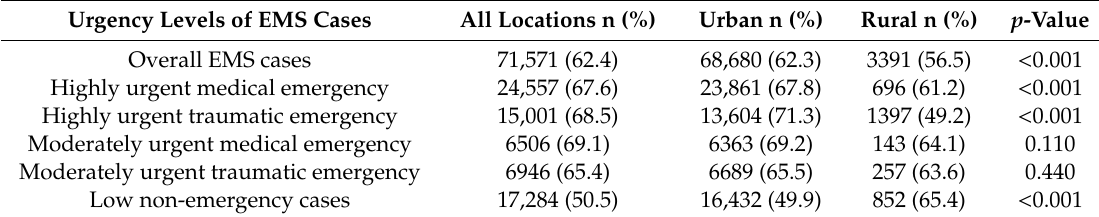
Table 5. Percentage of Response Times in 20 min or Less Based on Urgency